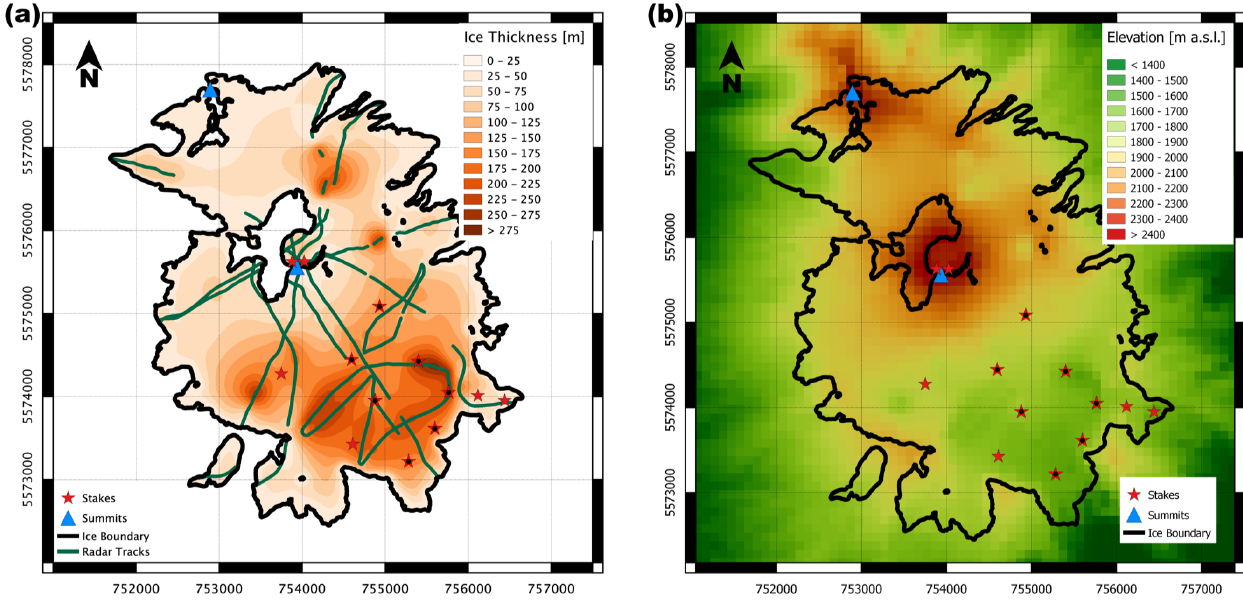
Figure 2. (a) Ground penetrating radar (GPR) transects shown in green lines together with the interpolated ice thickness. (b) Bedrock topography obtained after subtracting the interpolated ice thickness from surface elevation. This topography is used as the ice cap base in our